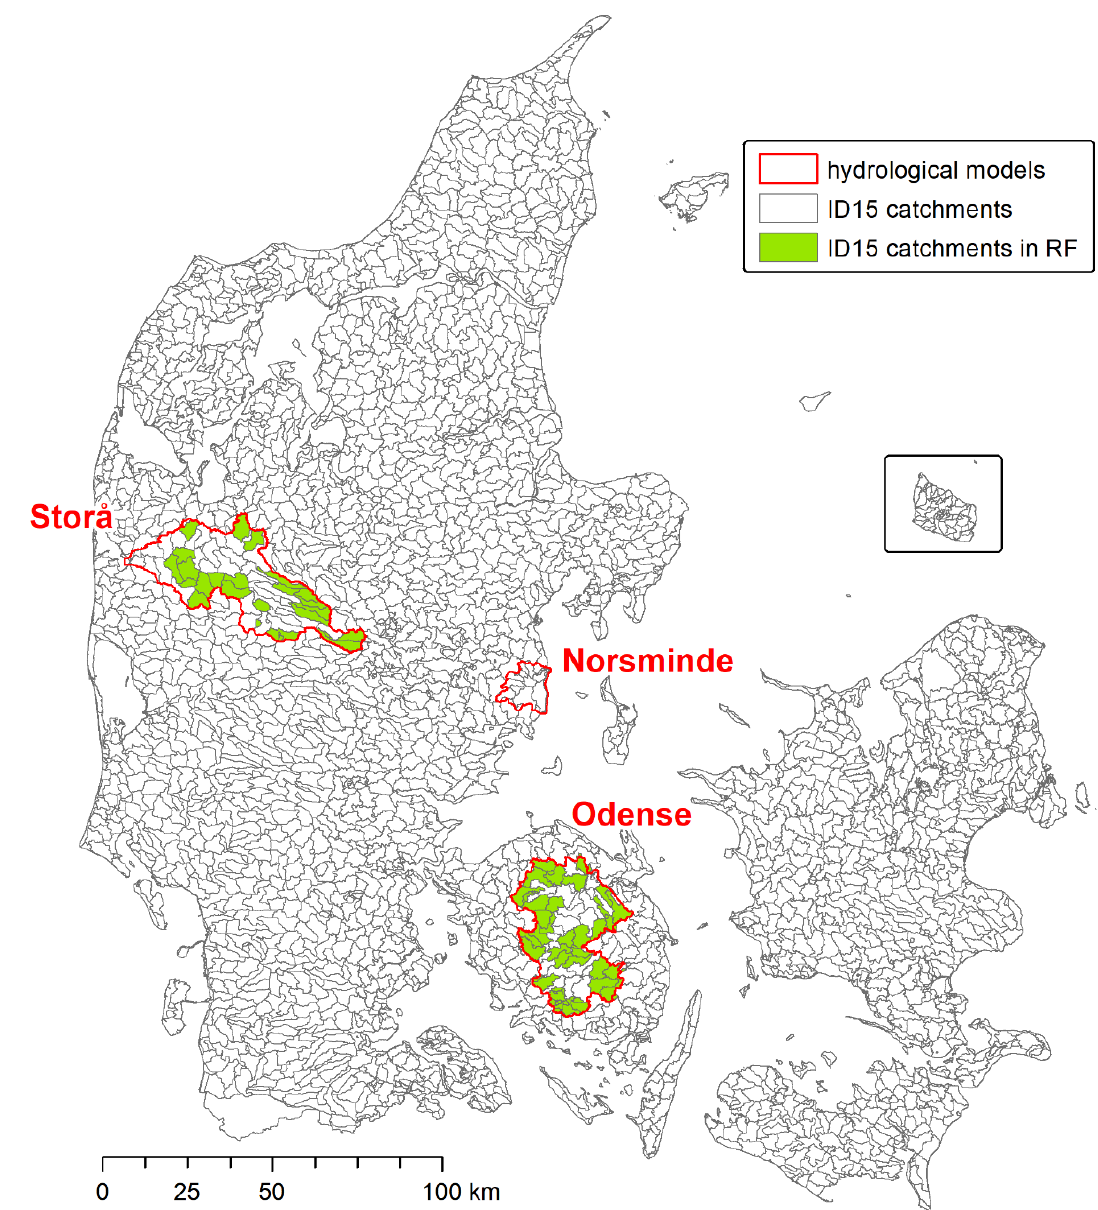
Figure 2. Map of Denmark divided into topographic catchments with an average size of approxi- mately 15 km 2 (ID15 catchments, grey outlines). Model areas are outlined in red, where Norsminde is the hydrological model used in the calibration exercise. The larger Odense and Storå catchments were used in the Random Forest regression. Here, the used ID15 catchments are marked green.